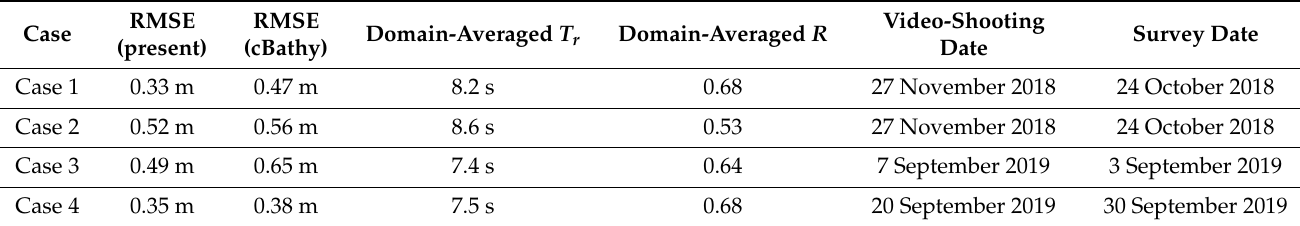
Table 3. Validation results: RMSE averaged over the transects, domain-averaged wave period and cross-correlation, and video-shooting and survey